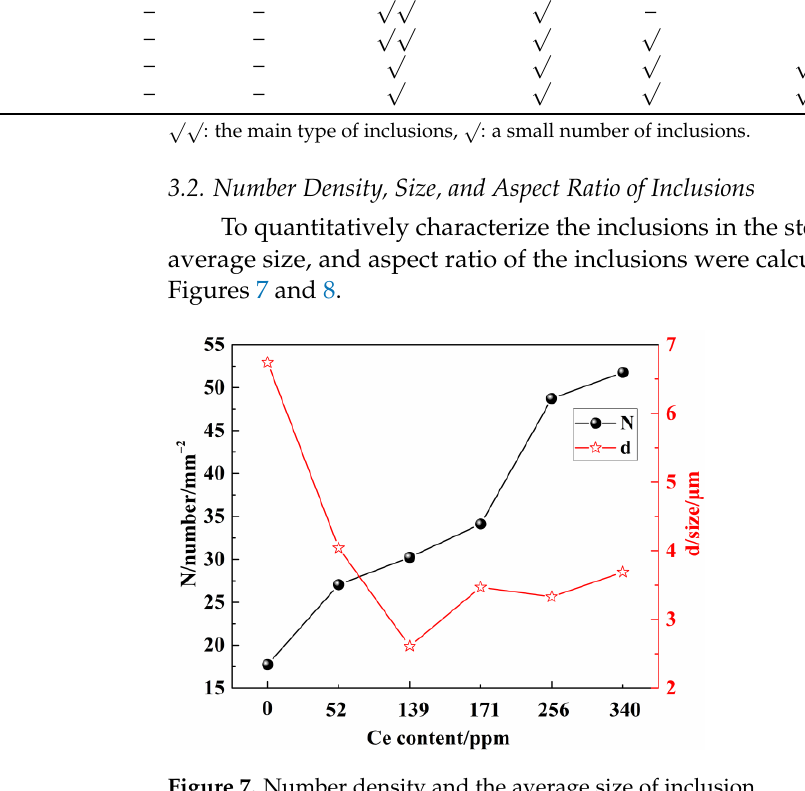
Figure 7. Number density and the average size of inclusion.